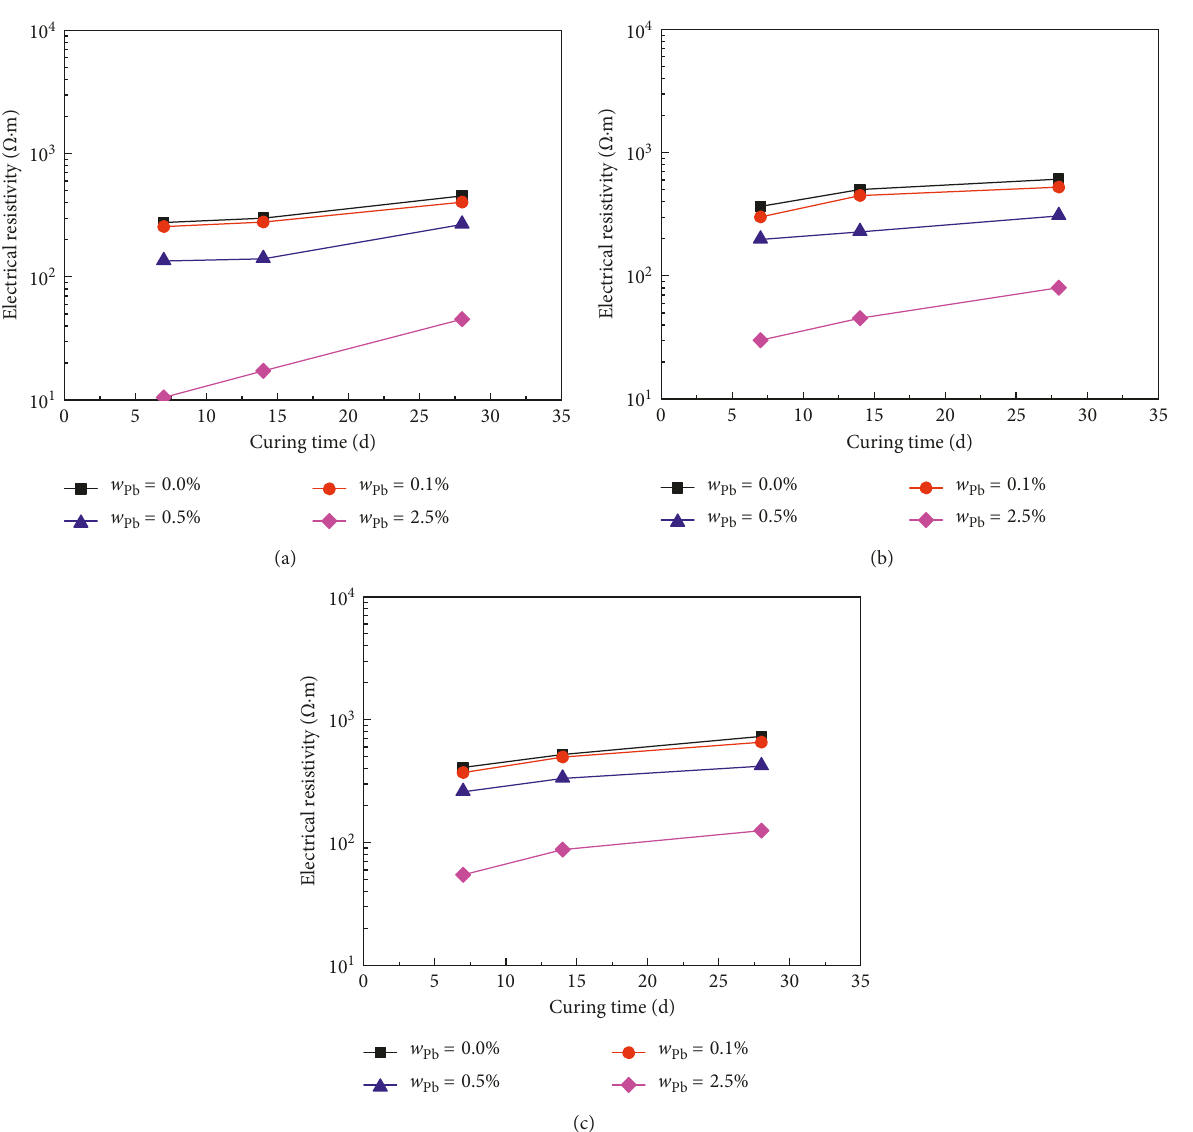
w (cid:31) 9%; (b) a w (cid:31) 12%; (c) a w (cid:31)